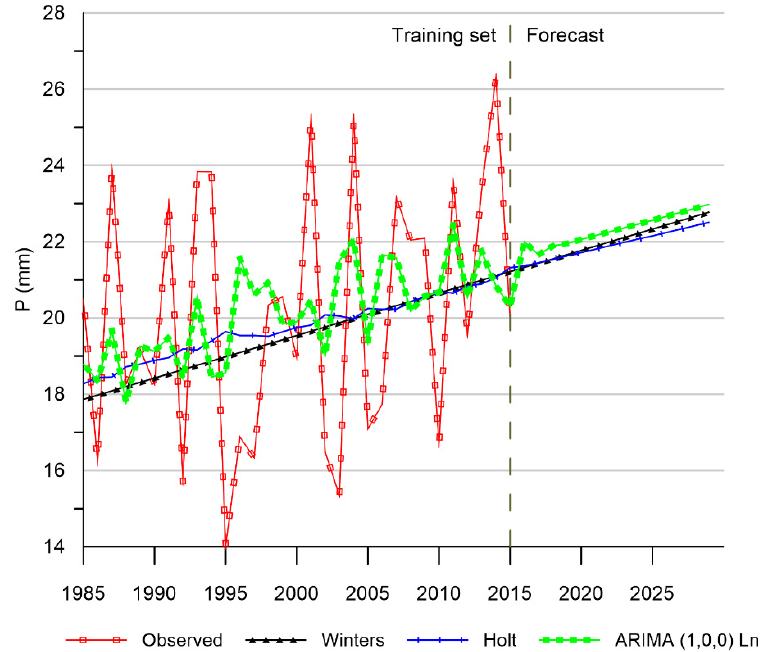
Figure 6. Maximum rainfall recorded in 24 h of each month averaged per year, forecasted with ARIMA and exponential smoothing